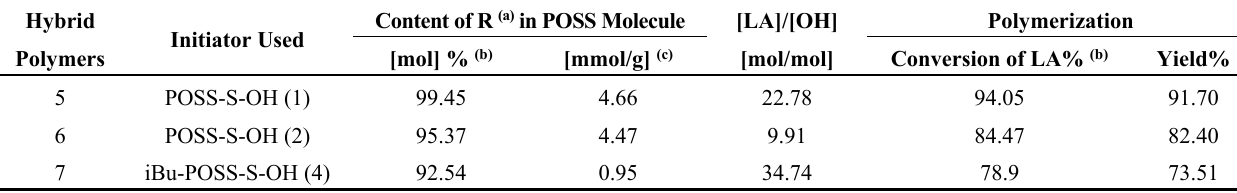
Table 2. Synthesis of star-shaped (POSS-S-PLA) and linear (iBu-POSS-S-PLA) hybrids.